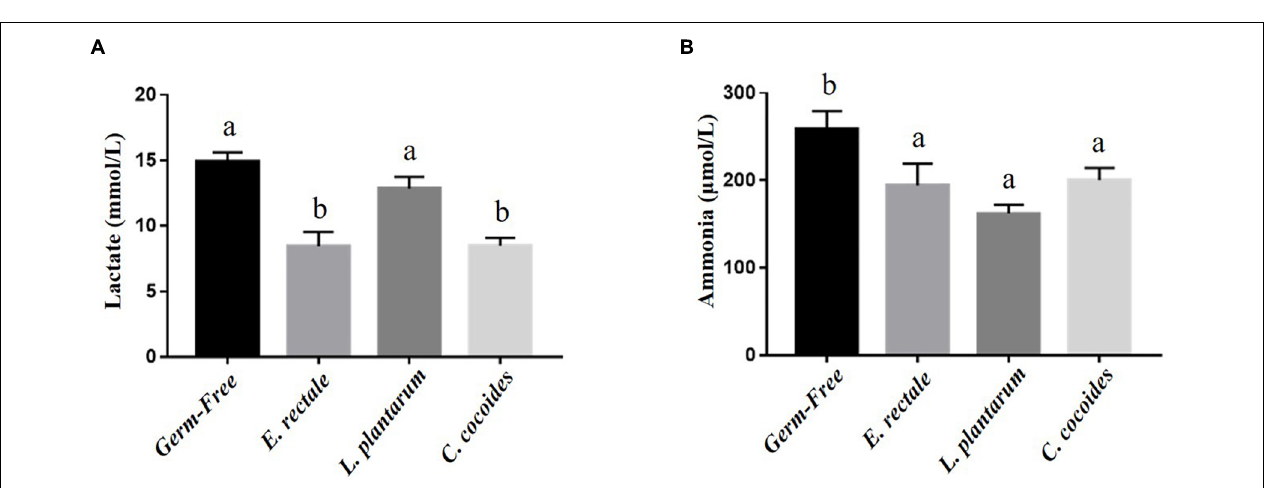
FIGURE 4 | Effect of indicated gnotobiotic groups on the serum lactate (A) and ammonia (B) levels after the exercise challenge. Data are mean ± SEM ( n = 6–8/group) and the columns with different superscript letters (a,b) are significantly different at P <